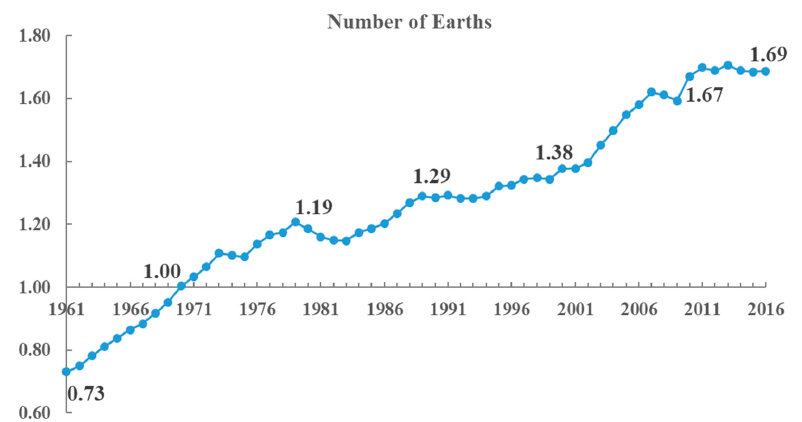
Figure 2. Evolution of “number of Earths” needed (1961–2016). Data source: National Footprint Account results (2019 Edition) from the GFN.